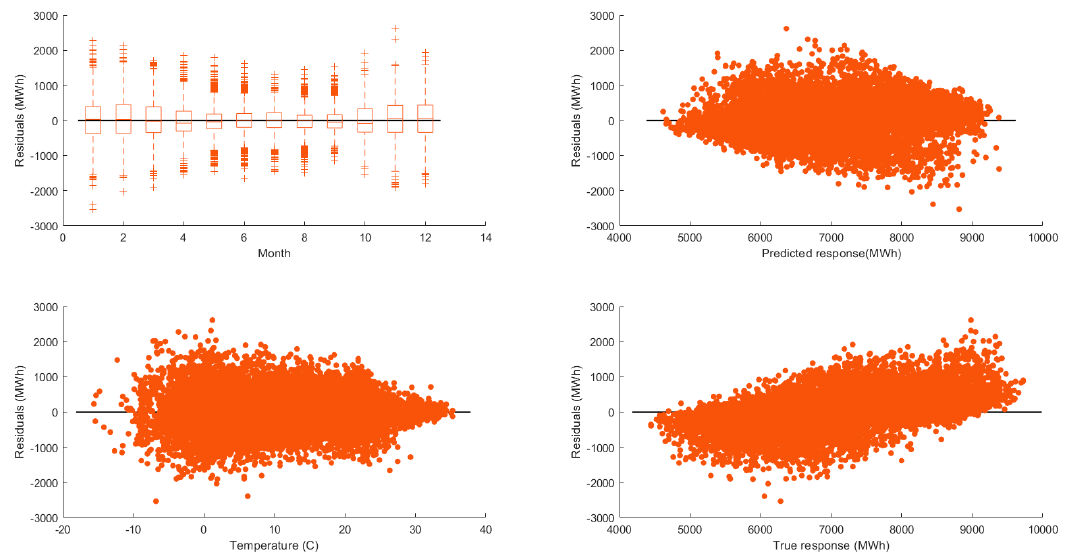
Figure 8. Residuals plot: ( a ) month predictor; ( b ) predicted response comparison; ( c ) temperature predictor; ( d ) true response